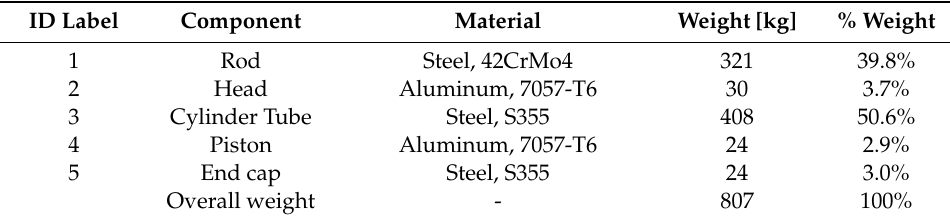
Table 2. Weight of the reference hydraulic cylinder parts.